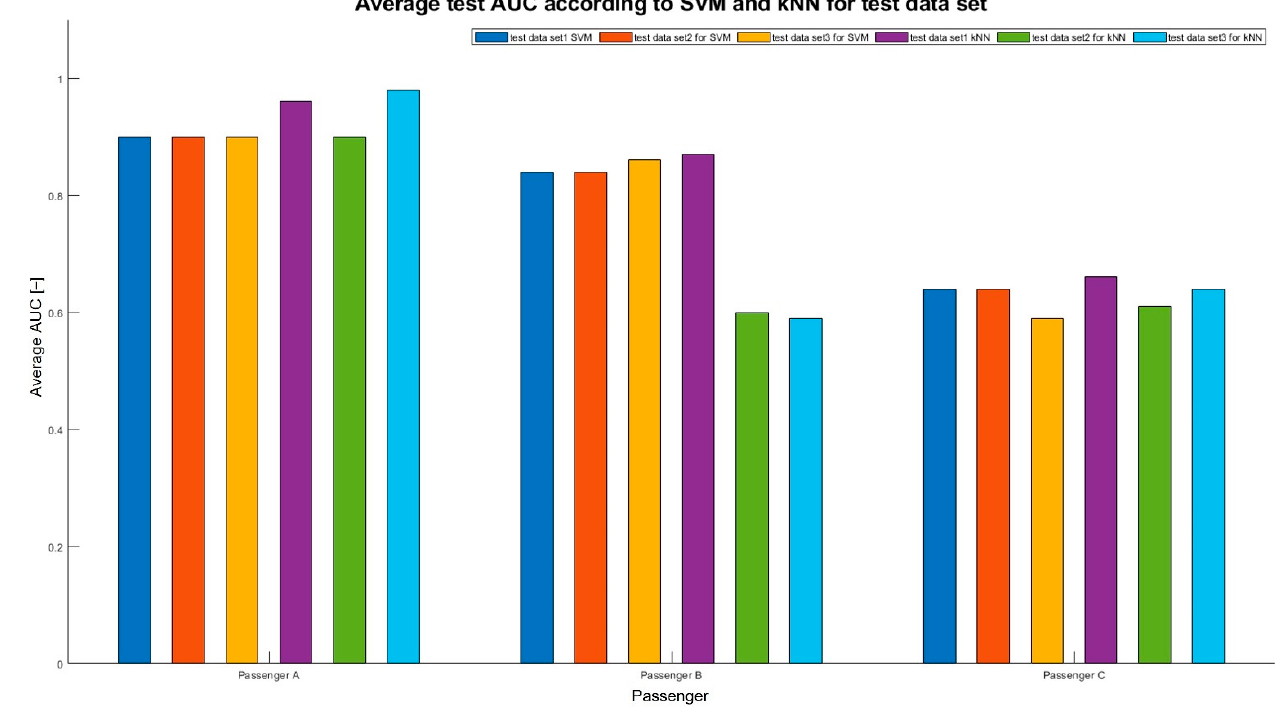
Figure 9. Average test AUC of all the passenger